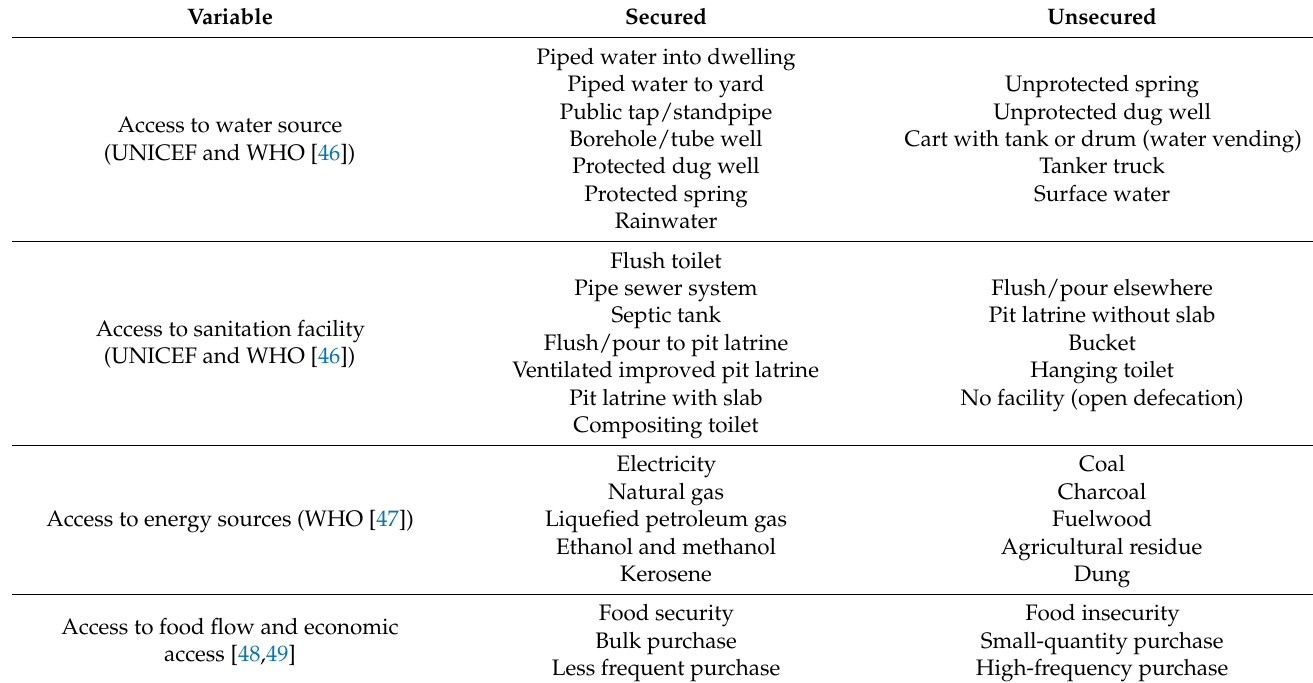
Table 2. Classification of household water, energy and food based on secure and unsecure access informing the questionnaire.